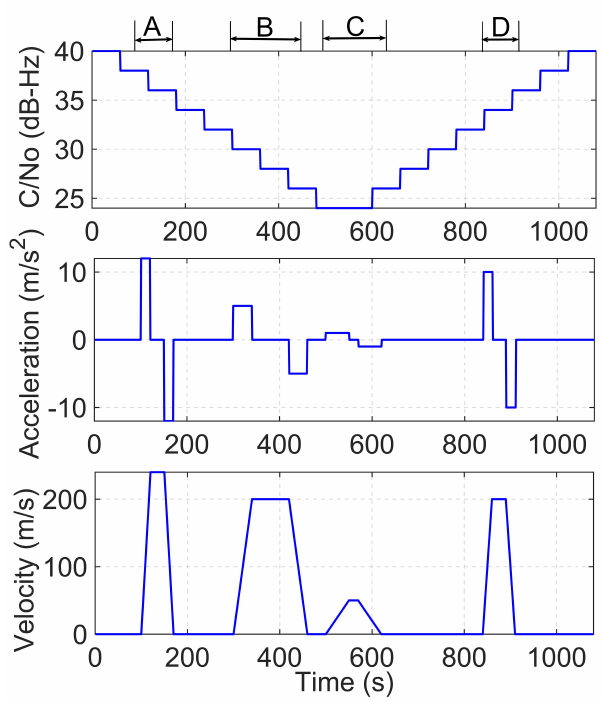
Figure 8. Dynamic weak signals used for the